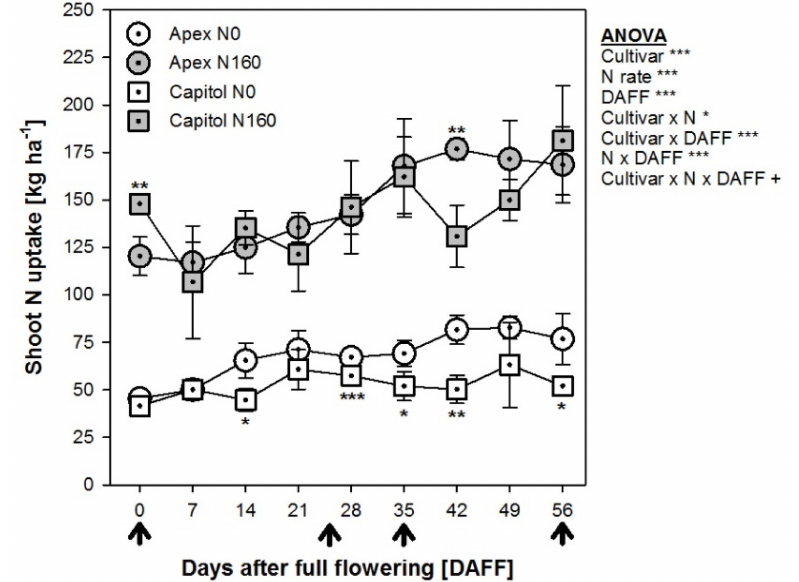
Figure 4. Shoot N uptake from full flowering until maturity of the winter oilseed-rape line-cultivars Apex and Capitol as affected by N fertilization rate (N0 and N160). The arrows indicate the developmental stages BBCH65, BBCH69, BBCH79, and BBCH89, respectively. ANOVA: +, * , and *** indicate significant differences at p < 0.10, p < 0.05, and p < 0.001, respectively. ns = non-significant. Individual DAFF: * , ** , *** indicate significant differences between the cultivars within the N fertilization rates at p < 0.05 and p < 0.01 and p < 0.001, respectively. The error bars (visible only when greater than the symbols) represent the standard deviations of the means ( n =